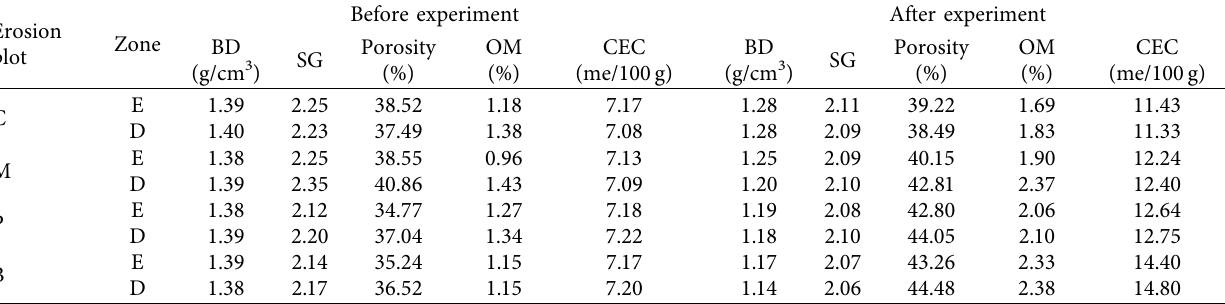
Table 4: Changes in soil characteristics before and after experiment.